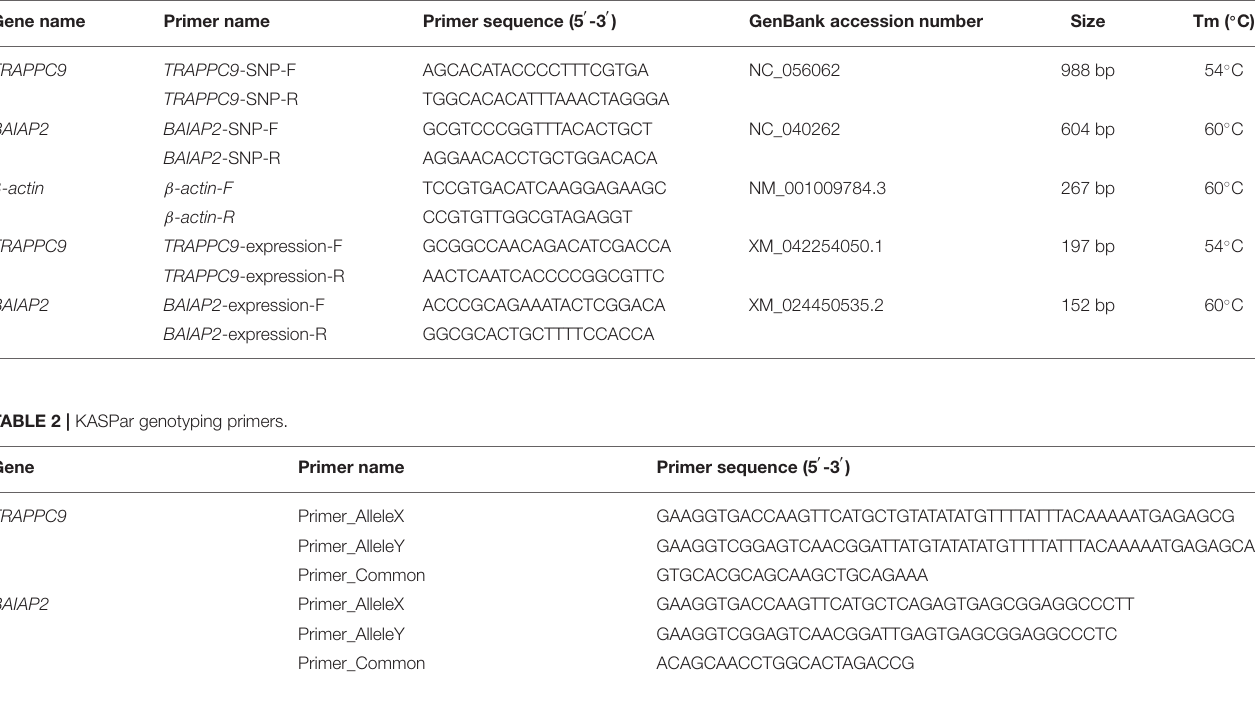
( Table 1 ). Using mixed DNA (n = 20), the PCR products were sequenced using Sanger sequencing to determine the SNPs of TRAPPC9 and BAIAP2 . The PCR reaction (35 µ L) included